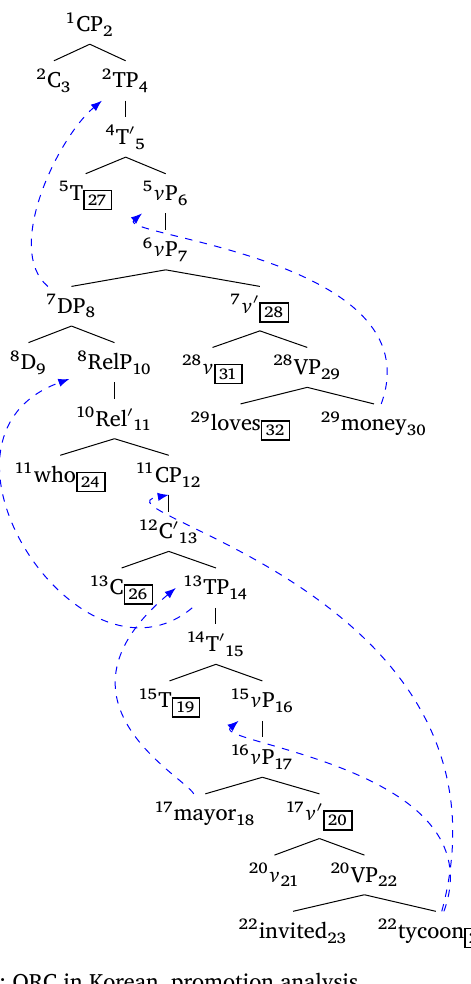
Figure 13: ORC in Korean, promotion analysis